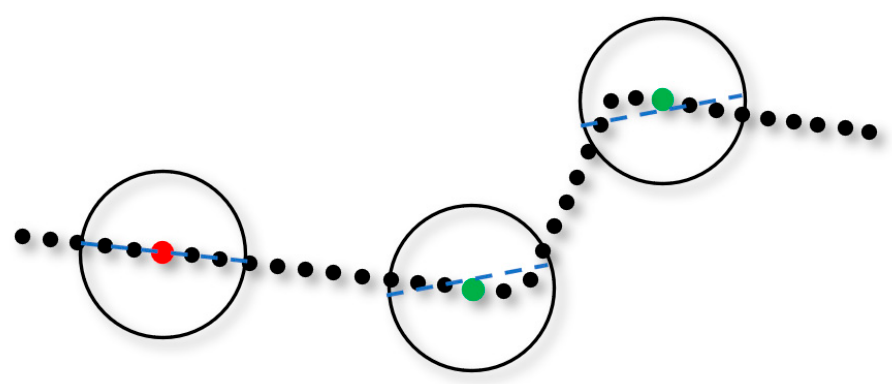
Figure 4. An example of an invalid keypoint elimination method based on LS fitting. The blue dashed lines represent the results of LS fitting in the neighborhood of the keypoints. The green and red dots represent the valid and invalid keypoints, respectively.